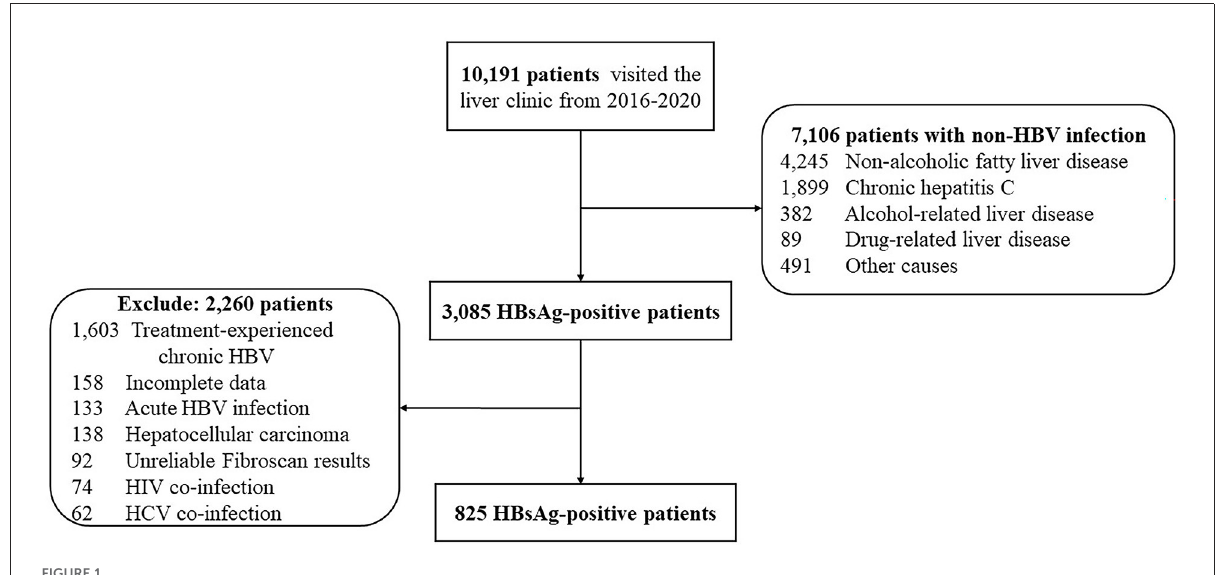
FIGURE1 Flow chart of patient enrollment.